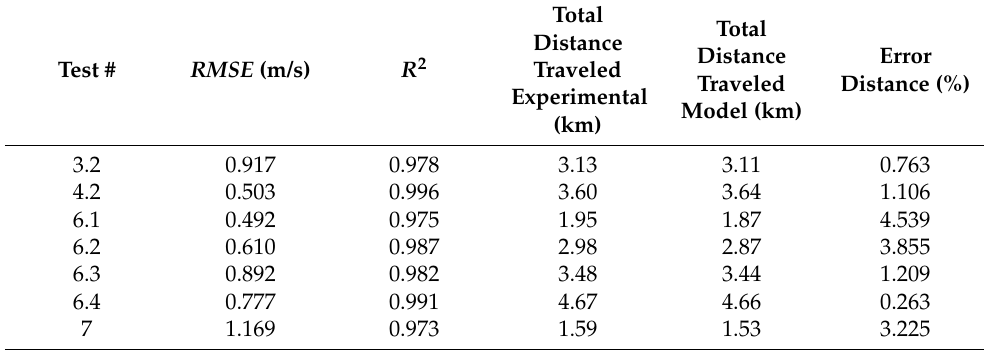
Table 14. Prediction metrics of global model performance over testing